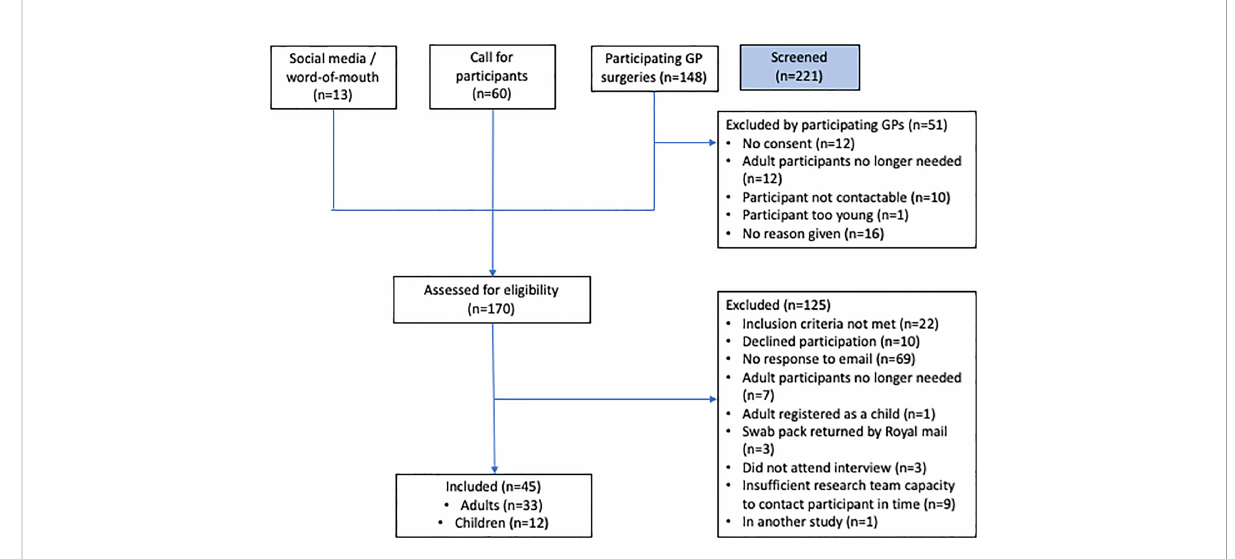
FIGURE 1 Recruitment fl ow